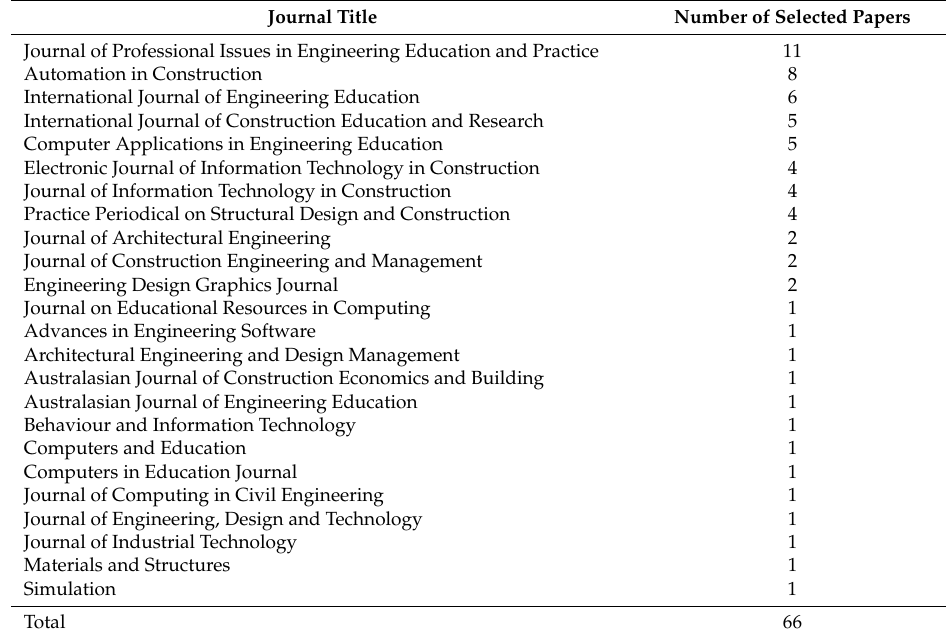
Table 2. Distribution of the selected journal papers by publication